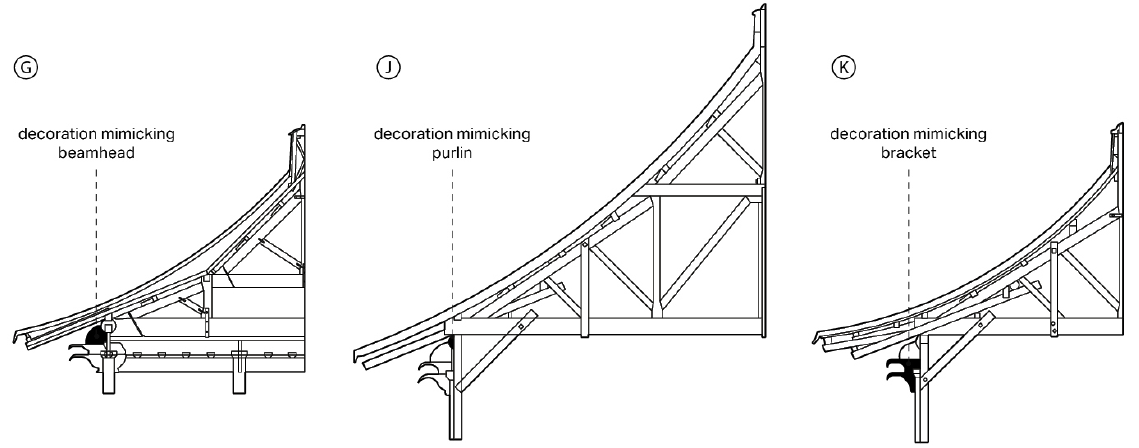
Figure 16. Decorations Added to Mimic Traditional Beamhead, Purlin, and Bracket of Original Traditional Korean Roof.